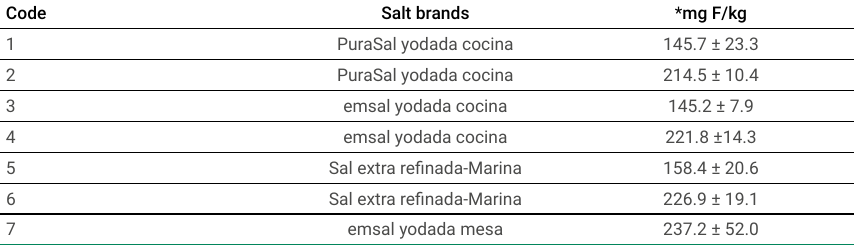
Table 2. Code, salt brands and mean (± SD; n= 6) of fluoride concentration (mg F/kg) found in the samples of salt